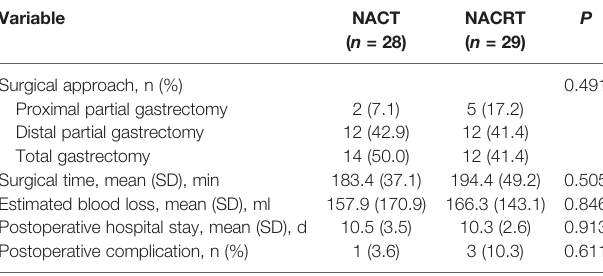
TABLE 3 | Surgical Outcomes. TABLE 4 | Pathological results in patients with